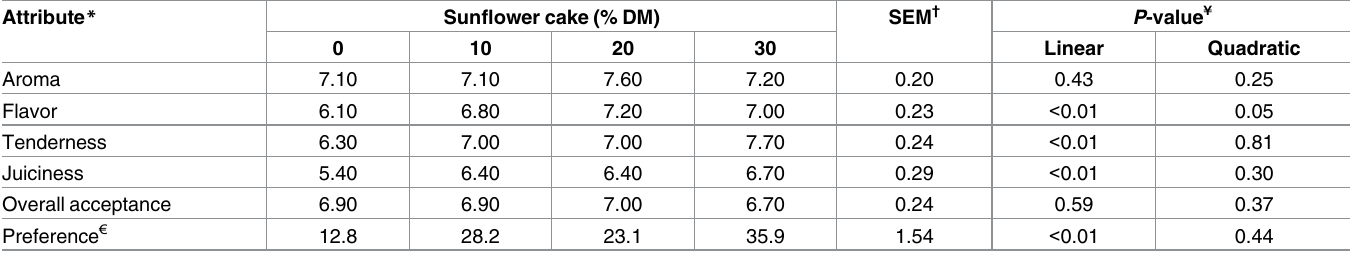
Table 5. Sensory attributes of the longissimus lumborum muscle of Santa Ines lambs fed sunflower cake. Attribute *